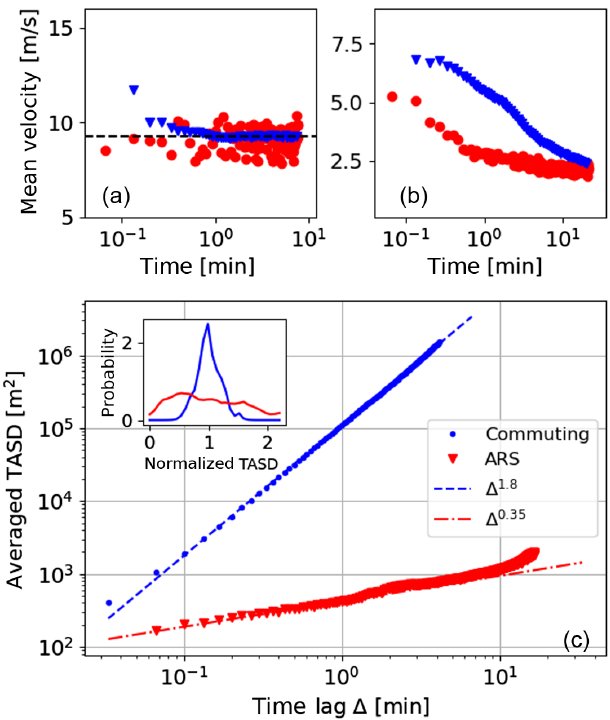
respectively.FIG. 2. (a,b) Ensemble-averaged (red circles) and time- averaged (blue triangles) velocities of empirical movement tracks of a kite during commuting (a) and ARS (b). The dashed line in (a) denotes the long-time limit of the ensemble-averaged and time-averaged velocities. (c) Empirical averaged TASD [Eq. (3)] of ARS segments (red triangles) and commuting segments (blue dots). The dashed (blue) and dash-dotted (red) lines are power laws with Δ 1 . 80 and Δ 0 . 35 , respectively. The inset shows the probability density of TASD normalized by its average at time lag Δ ¼ 0 . 33 ≪ t (see text), for both